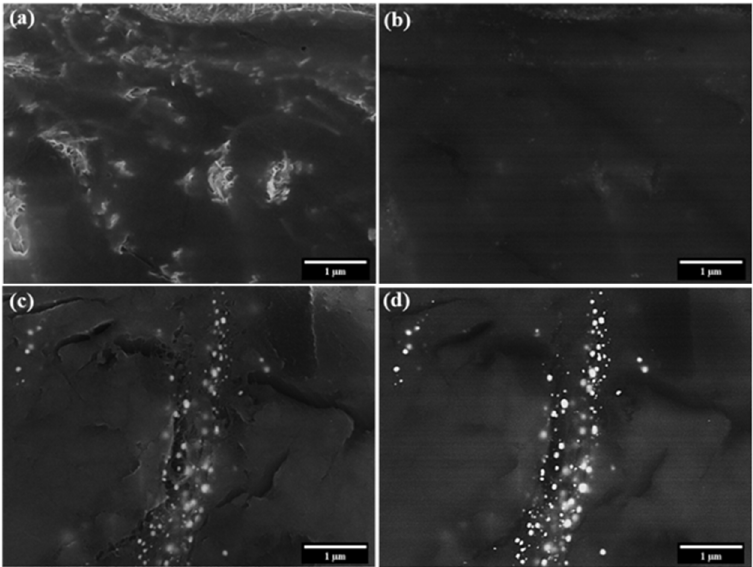
Figure 13. SEM imaging of 0.75 wt% CNT nanocomposites made from: untreated CNTs ( a ) SE image ( b ) BSE image; Eu:Y 2 O 3 -CNTs ( c ) SE image ( d ) BSE image.